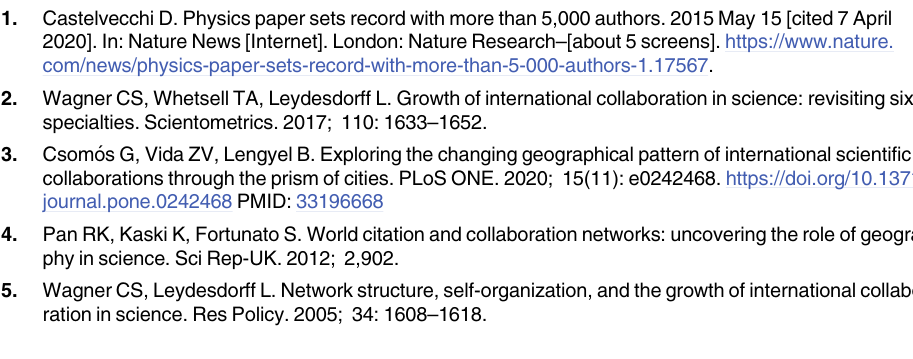
S1 Table. Number and share of peripheral cities by continents. S2 Table. Composition of editorial boards in terms of the share of editors from different continents. S3 Table. Relationship between the share of editors from different continents and the Q- classification of journals as defined by WoS. S4 Table. Classification of the core cities into